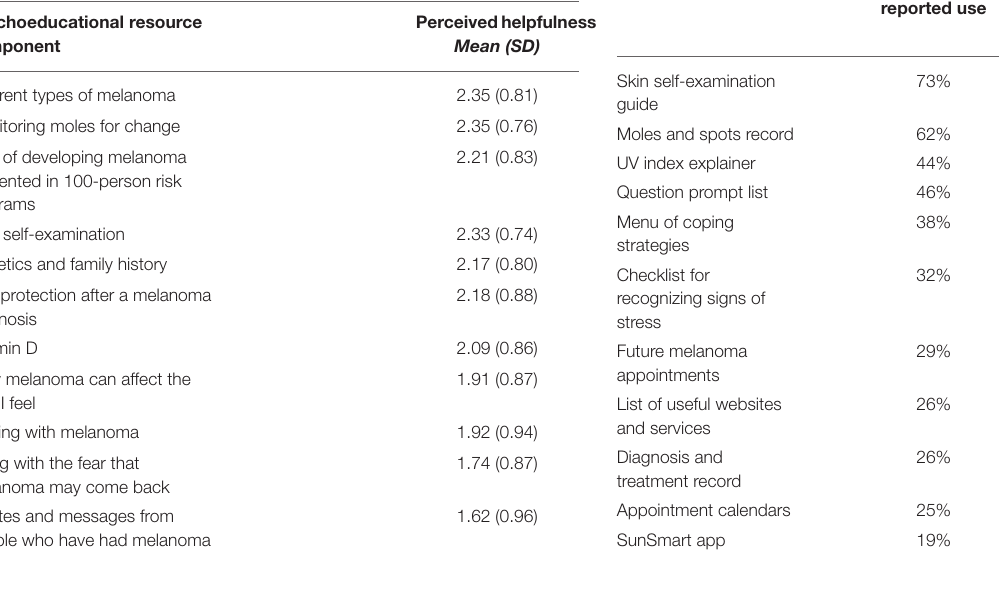
TABLE 4 | Mean perceived helpfulness ratings for each component of Melanoma: Questions and Answers ( n = 66), with ratings from 0 (“not at all helpful”) to 3 (“very helpful”).